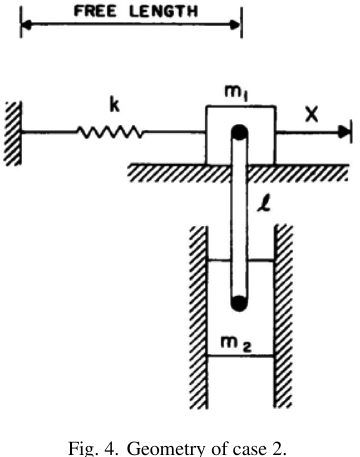
Fig. 4. Geometry of case